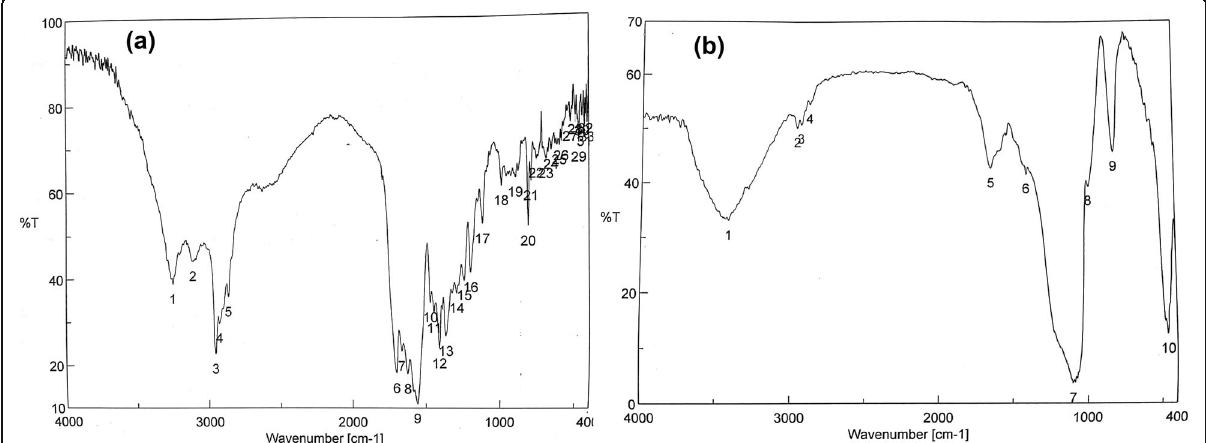
Fig. 4 FTIR spectra of a organic ligand C-2P and b grafted silica SC-2P